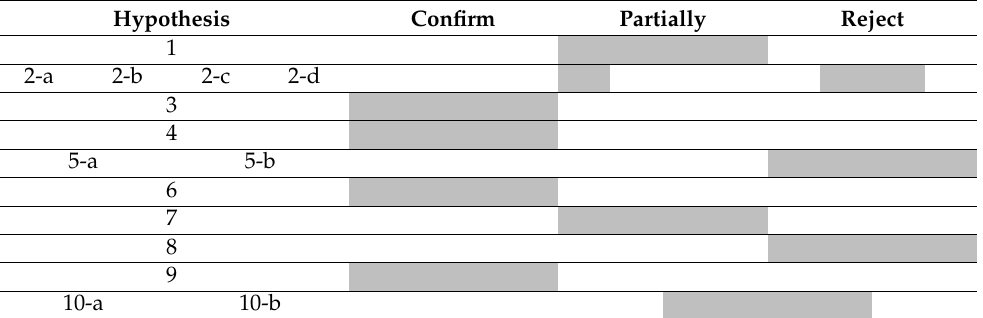
Table 5. Summary of results of tested